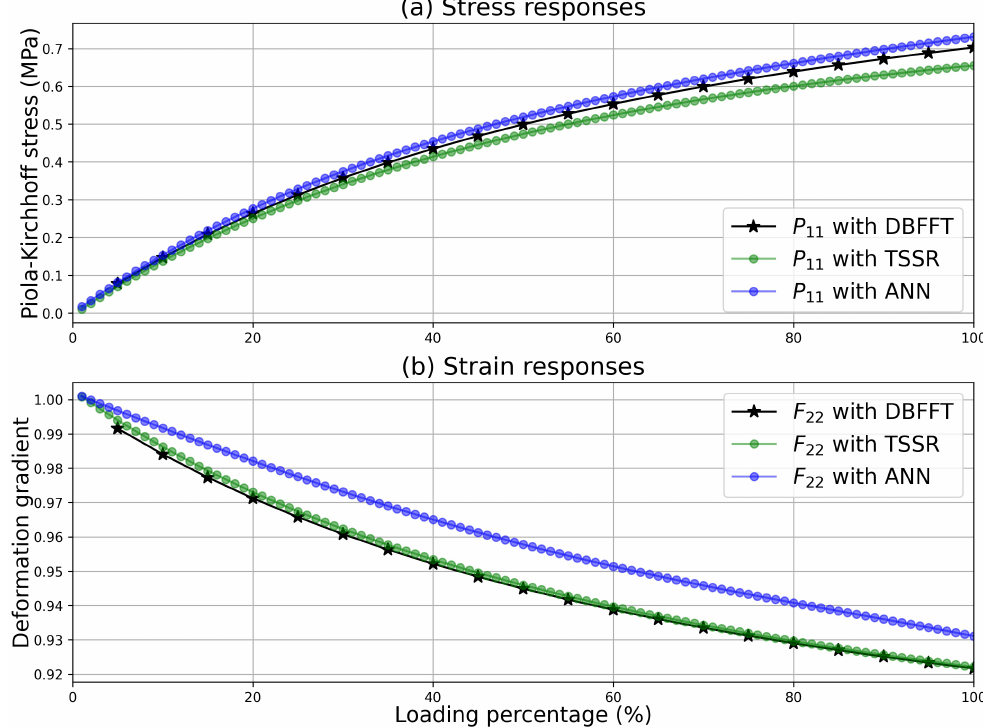
Figure 6. Stress and deformation gradient predictions with the trained ANN model, TSSR model, and the DBFFT full-field calculation. It shows ( a ) the component P 11 of the Piola–Kirchhoff stress and ( b ) the component F 22 of the deformation gradient as functions of the loading